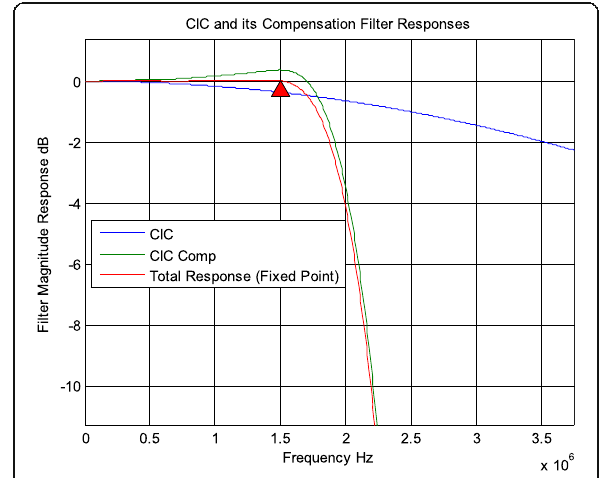
Fig. 8 CIC filter, compensation filter, and overall frequency response